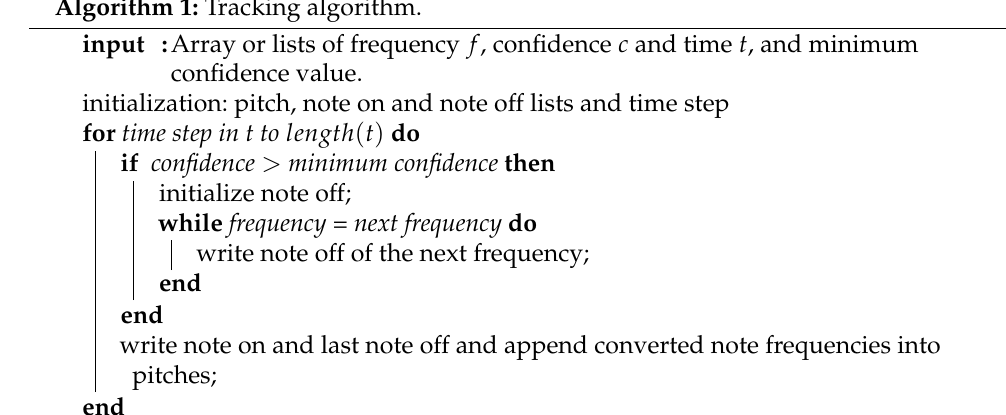
Algorithm 1: Tracking